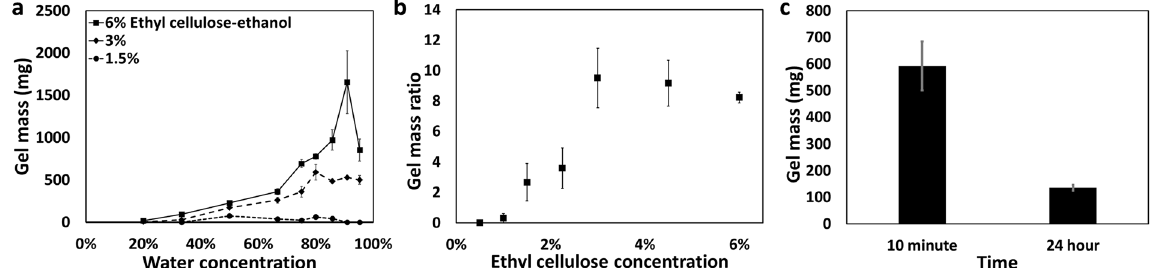
Figure 4. Gel mass is a function of water concentration, ethyl cellulose concentration and time. ( a ) Gel formation rates were a function of both on ethyl cellulose concentration and the ratio of water to ethanol (n = 3). ( b ) The gel mass ratio (i.e., the ratio of the gel mass to the mass of ethyl cellulose in the initial ethyl cellulose-ethanol solution) was a function of initial ethyl cellulose concentration. These solutions were 80% FBS-PBS (denoted “water”) and 20% ethyl cellulose-ethanol (n = 3). ( c ) Gel mass formation as a function of time (n = 3). All error bars depict standard error.